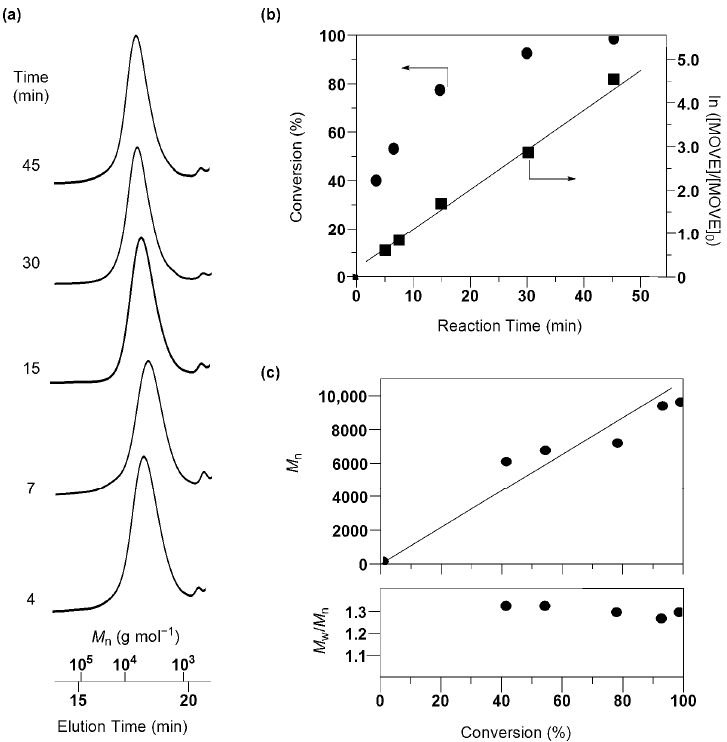
Figure 4. ( a ) SEC curves of SP-PMOVE measured in THF, ( b ) a time-conversion curve and first-order kinetic plot for the polymerization of MOVE, and ( c ) M n and M w / M n values of SP-PMOVE plotted against monomer conversion. Polymerization was conducted with SPVE-TFA/EtAlCl 2 /dioxane in toluene at 0 °C ([MOVE] 0 = 1000 mmol L − 1 , [EtAlCl 2 ] 0 = 20 mmol L − 1 , [dioxane] 0 = 900 mmol L − 1 , [SPVE-TFA] 0 = 10 mmol L − 1 ).